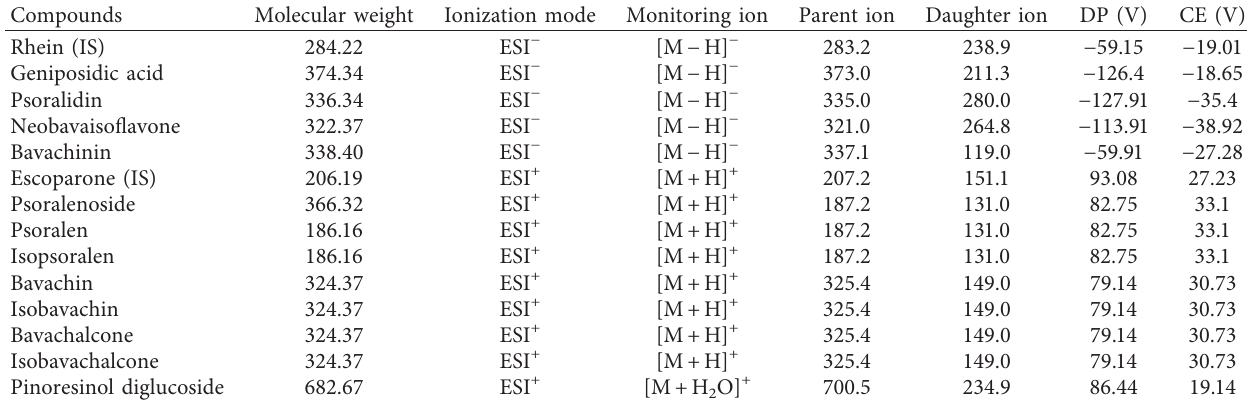
Table 1: The precursor ions, product ions, declustering potential (DP), and collision energy (CE) for each analyte and internal standard (IS) in negative and positive ionization